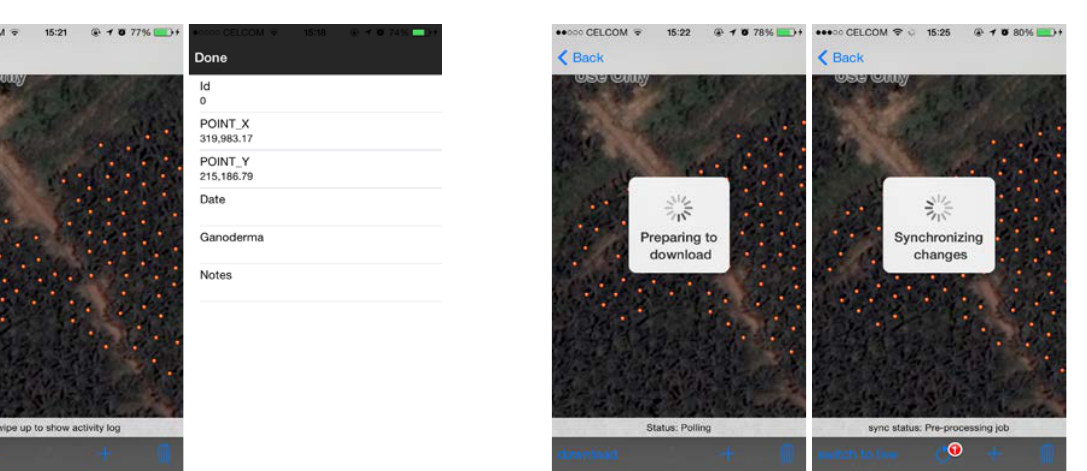
Figure 4. Screenshots of downloading and synchronizing